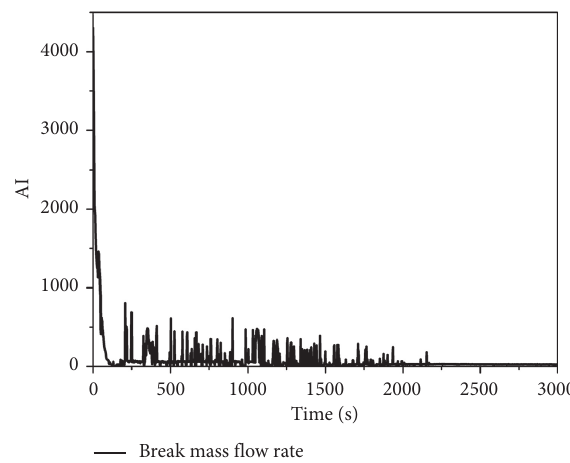
Figure 6: 10-inch SBLOCA break mass flow rate.